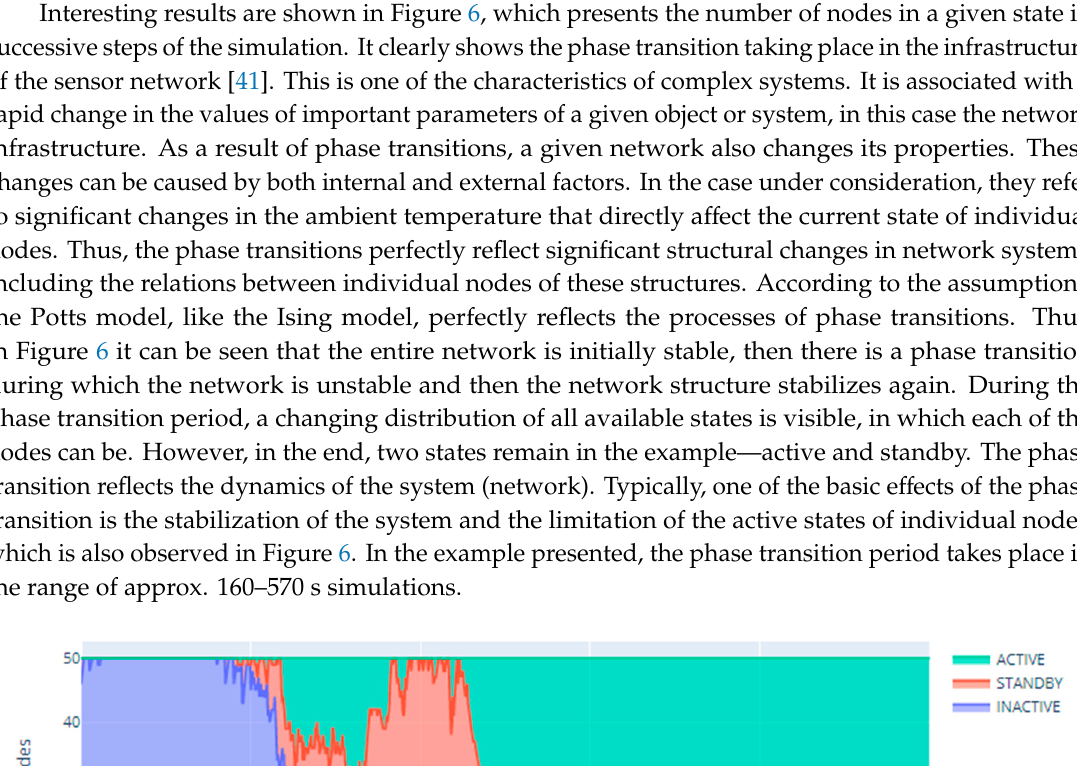
Figure 5. Selected steps of the simulation; ( a ) heat map in 459 s; ( b ) states of individual nodes in 459 s; ( c ) heat map in 991 s; ( d ) states of individual nodes in 991 s.